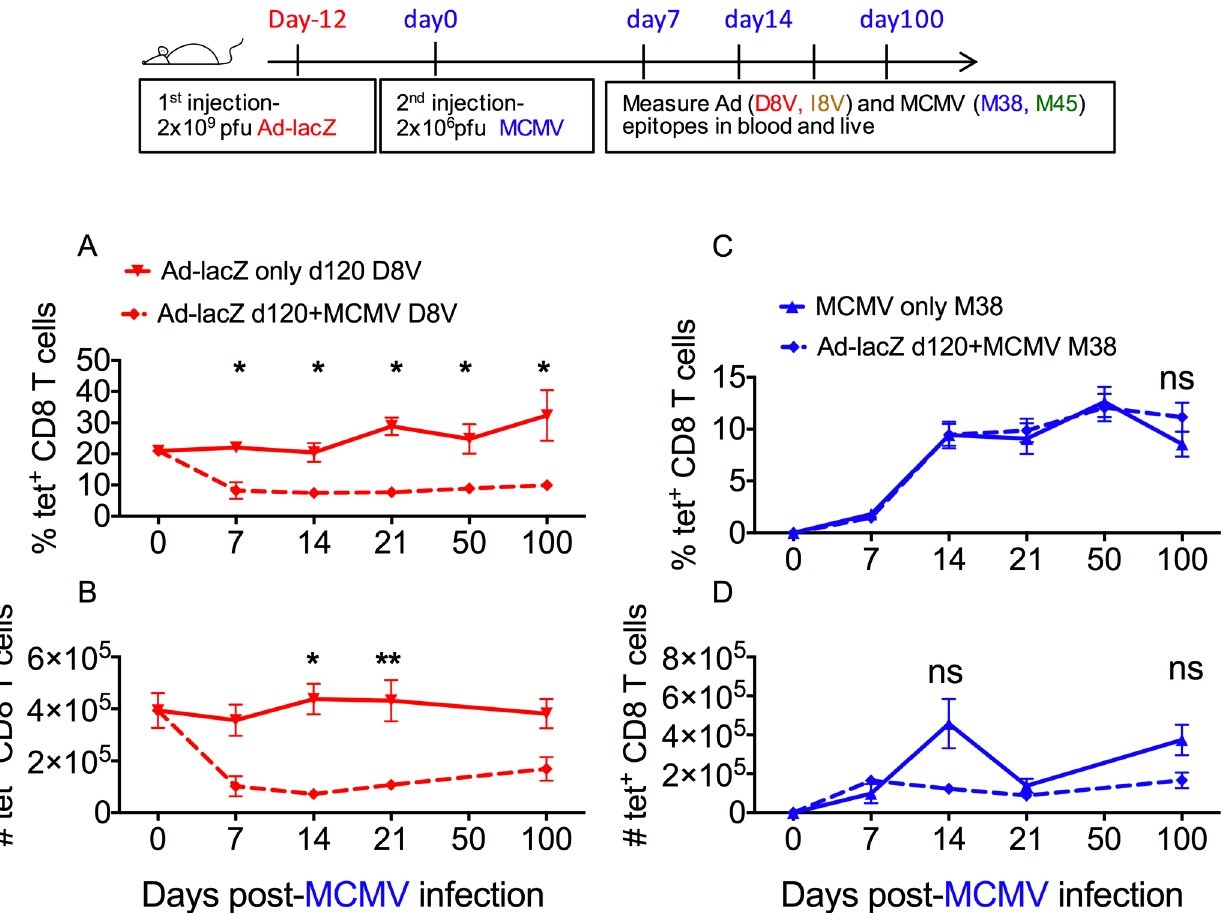
Fig 3. Sequential infection with Ad-LacZ followed by MCMV. C57BL/6 mice were first immunized with Ad-lacZ, then > 50 days later were infected with MCMV. The size of the pre-existing Ad-lacZ specific M38 effector memory response after MCMV infection was measured in the blood and liver by ex-vivo tetramer staining. (A) The percentage of pre-existing inflating D8V tetramer+ population in the blood and (B) the absolute numbers in the liver after MCMV infection was determined at the indicated time points. (C) The kinetics and magnitude of the new inflating response (M38) in groups of mice previously immunized with Ad-lacZ was also measured by ex vivo tetramer staining and compared against uninfected mice. The percentage of M38 tetramer + cells in the blood and (D) the absolute numbers in the liver was measured at the indicated time points. The figures show the mean from 3–8 mice per time point obtained from 2 independent experiments. p values were measured by Mann-Whitney tests followed by Dunn’s multiple comparison. (cid:3) p < 0.05, (cid:3)(cid:3) p < 0.005.